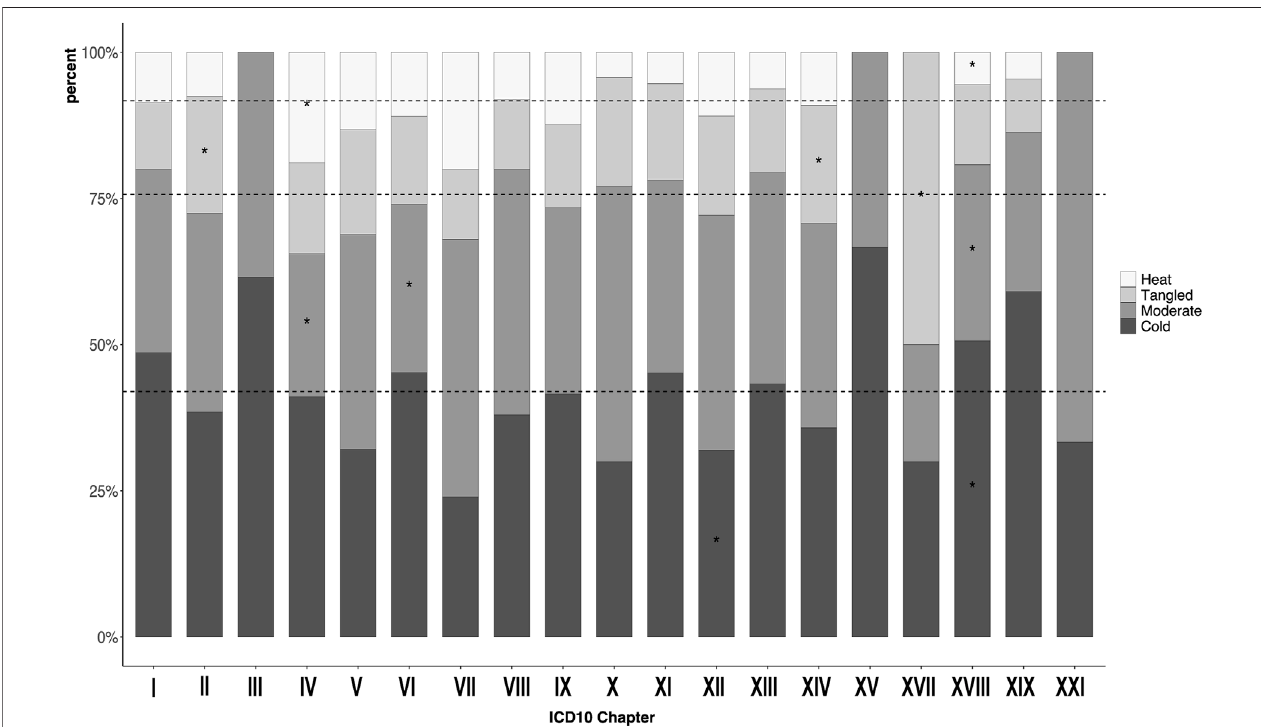
FIGURE 2 | Proportion of participants with heat-cold pattern in each the 10th version of the International Classi fi cation of Diseases chapters. * p < 0.05 ICD (cid:1) International Classi fi cation of Diseases. I: Infection (35); II: Neoplasm (200); III: Hemotology/Immunology (13); IV: Endocrine/metabolism (90); V: Psychiatry (106); VI: Neurology (146); VII: Ophthalmology (25); VIII:Audiology (50); IX: Circulatology (113); X: Pulmonology (70); XI: Gastroenterology (206); XII: Dermatology (147); XIII: Musculoskeletal (224); XIV: Genitourology (243); XV: Obstetrics (3); XVII: Congenital (10); XVIII: Symptoms/signs (474); XIX: Injury/poisoning (22); XXI: Health state